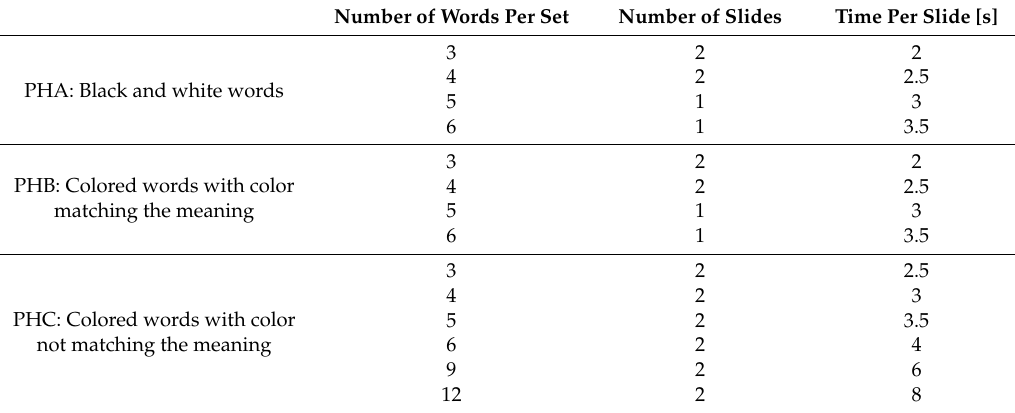
Table 1. Schedule of the Stroop test—in the first phase the words are in black and white, in the second phase the color of words matches the word meaning, and in the third phase the color of words does not match the word